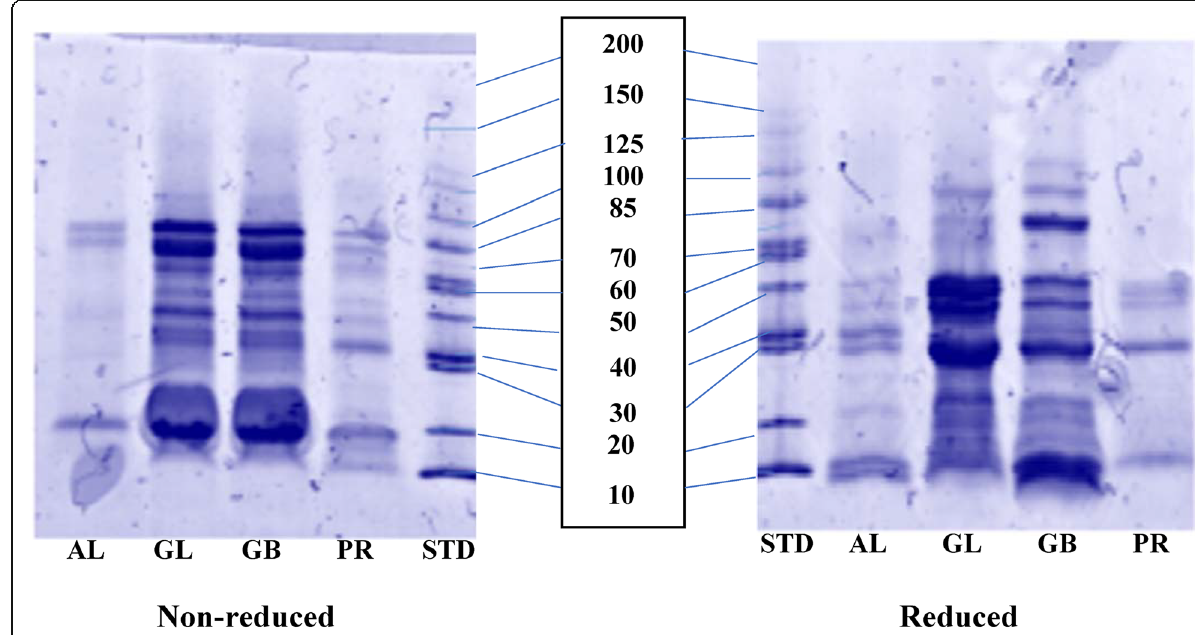
Fig. 1 SDS-PAGE of albumin (AL), glutelin (GL), globulin (GB) and prolamin (PR) sesame protein fractions